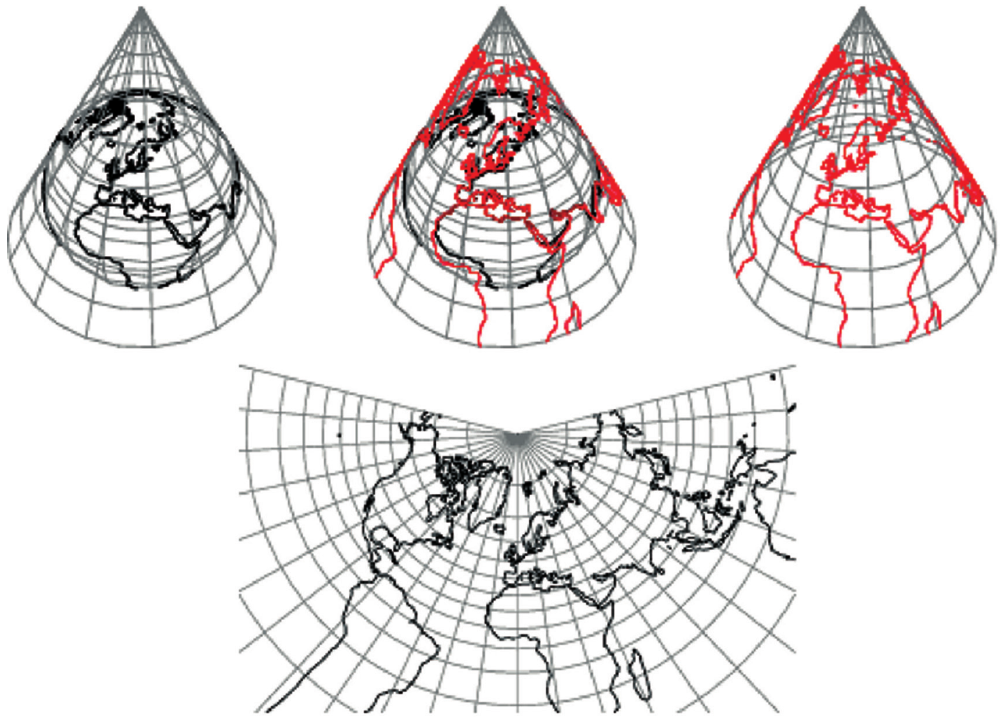
Fig. 10. Transformation of oblique spherical circle to tangent conical surface cut along the solid line and flattened out